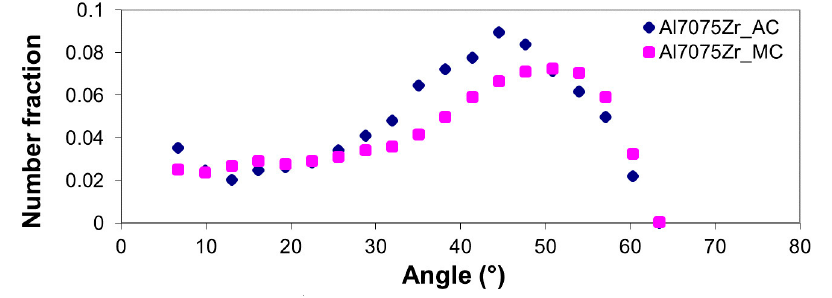
Figure 15. Distribution of grain boundary misorientation angles in both SPS compacts.